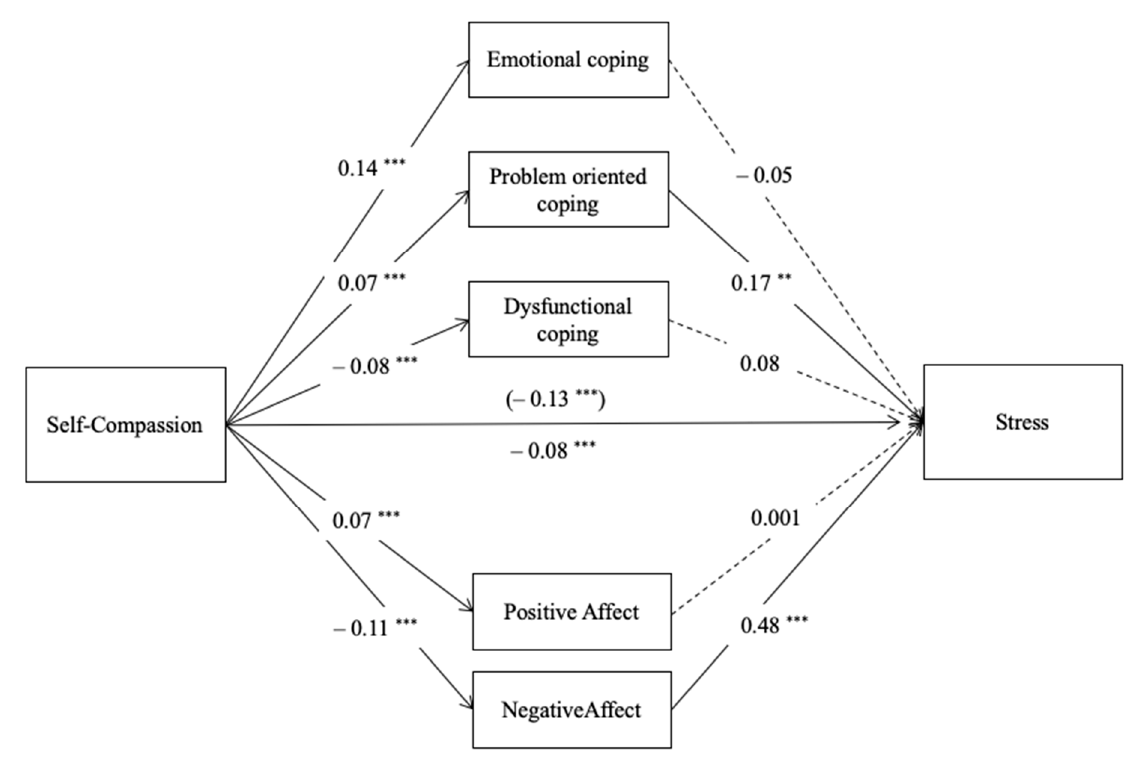
Figure 3. Parallel mediation model with path coefficients (unstandardized): self-compassion, positive affect, negative affect, emotional coping, problem oriented coping, dysfunctional coping and stress (M3). Note: ** p < 0.01, *** p < 0.001, c’ (direct effect) above the line and c (total effect) below the line, dashed lines are not-significant paths.